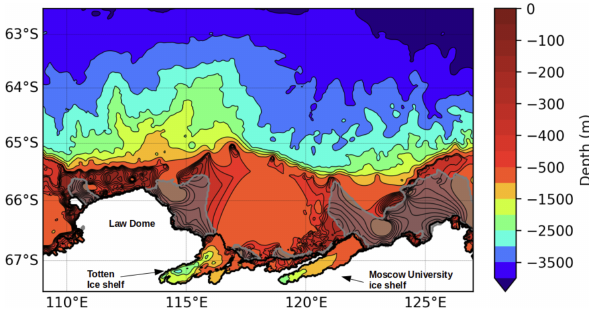
Figure 1. Model bathymetry and domain. The contour interval is 50m up to 500m depth and 500m up to 4500m depth. Ice shelf cavities are surrounded by a thick black line. The 0.75 fast ice ob- served frequency from Fraser et al. (2020) is shown by the shaded gray